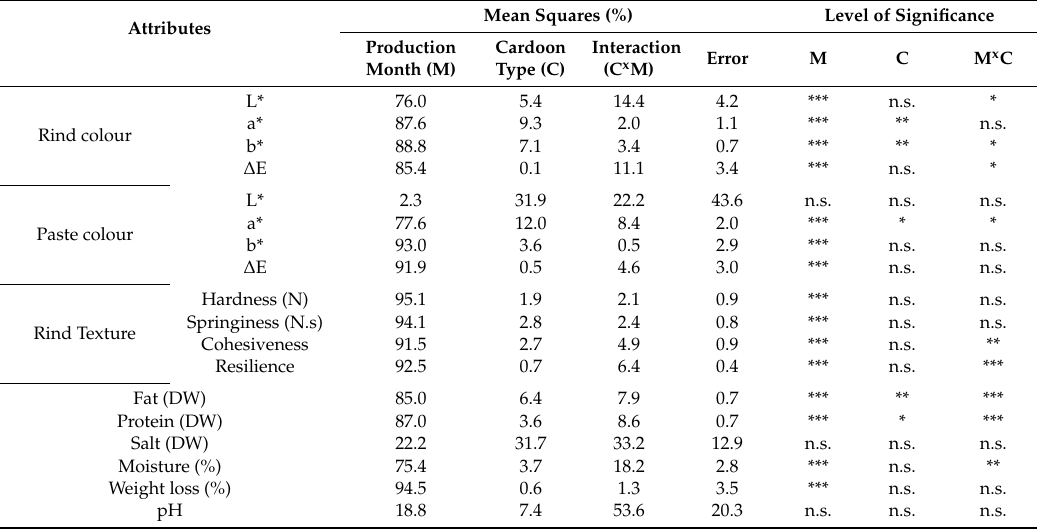
Table 2. Mean square percentages and statistical significance of cheese production month, cardoon type and their interaction. The level of significance is obtained by an ANOVA unifactorial model. Level of Mean Squares (%) Attributes